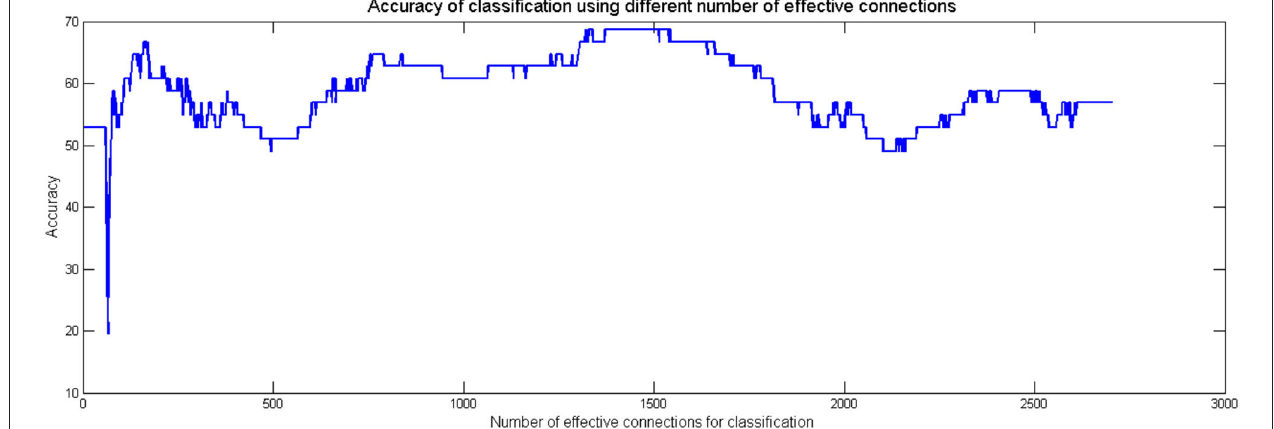
FIGURE 2 | The relationship between classification accuracy and the number of effective connections used in the classification process. The effective connections were ranked according to F scores in descending order.